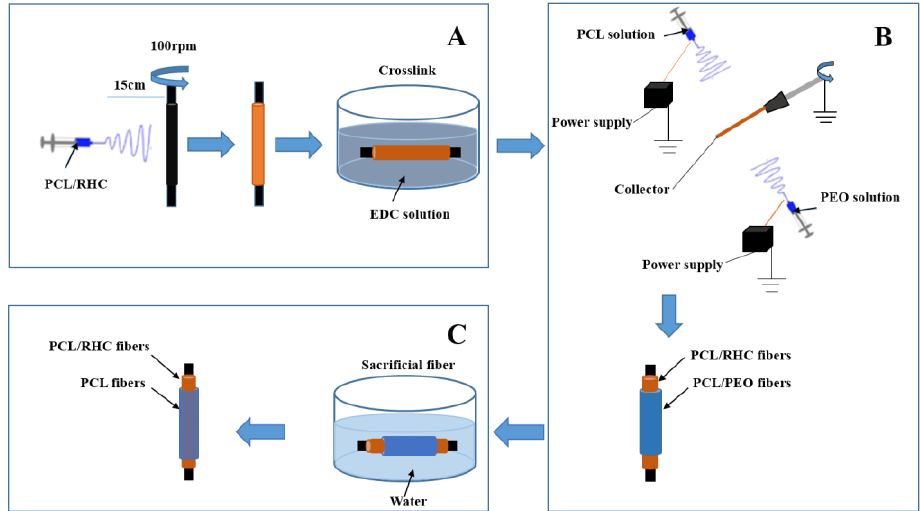
Figure 1. Schematic of the fabrication process of the bilayer scaffold: preparation of the inner layer ( A ), co-electrospinning of the outer layer of the scaffolds ( B ), removal of the PEO fibers ( C ).